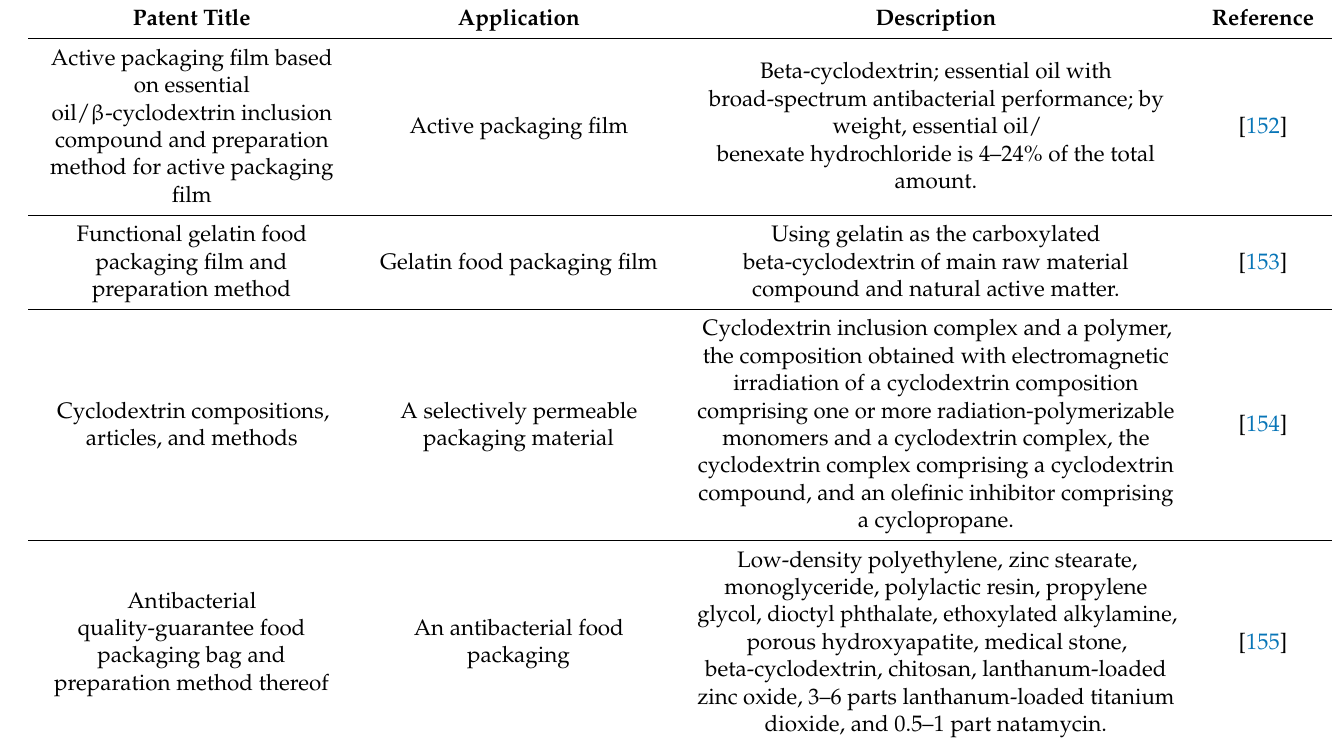
Table 5. Some patents using CDs in active food